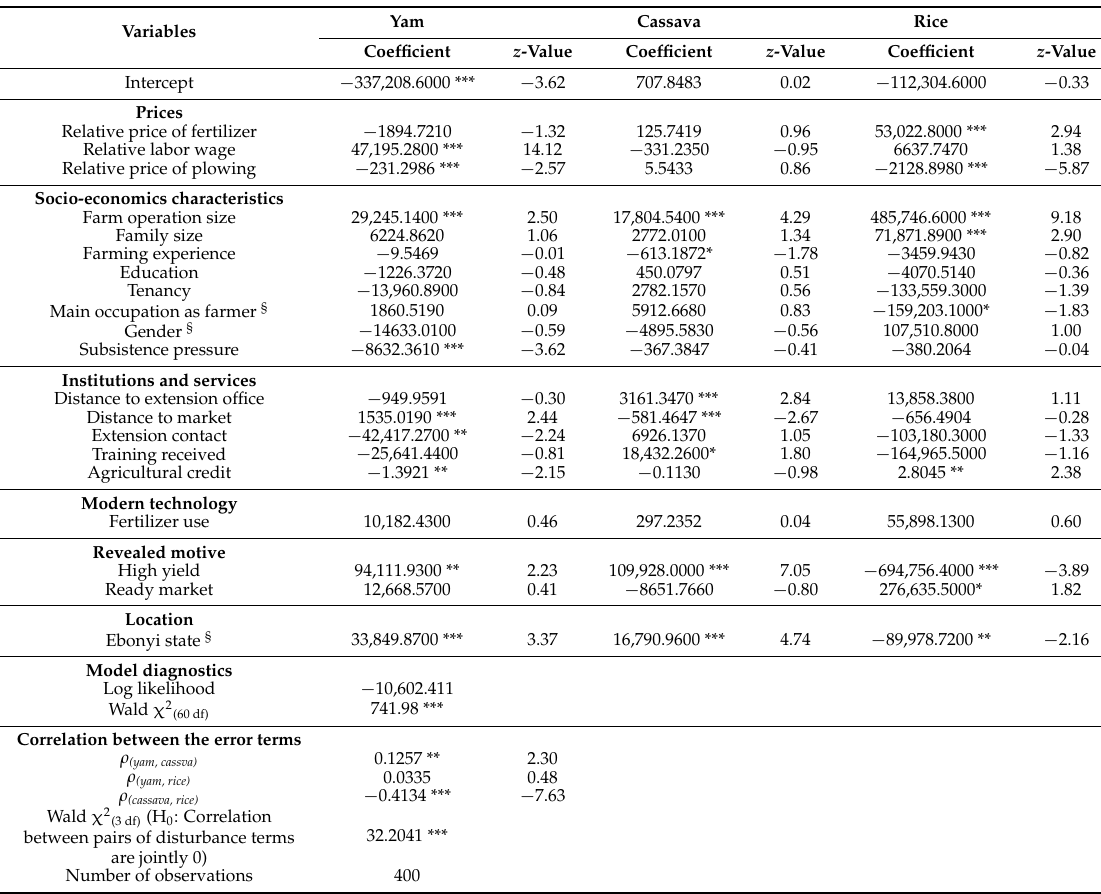
Table 3. Joint determination of factors influencing choice of crop diversity and profitability: a multivariate Tobit